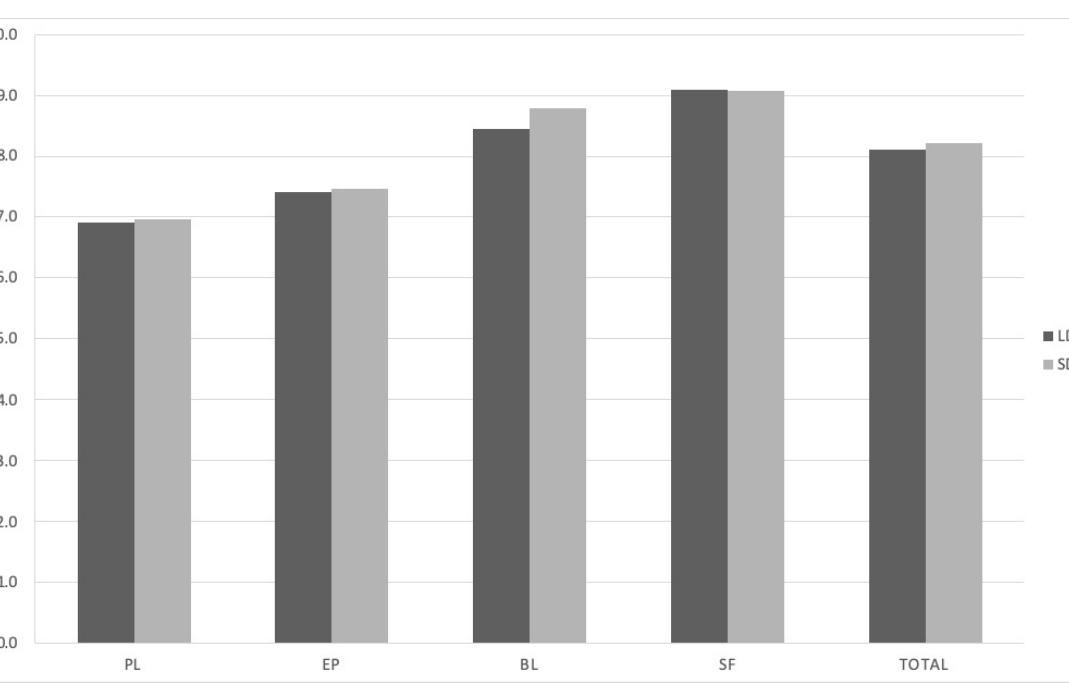
Figure 3. Assessment of the visibility of the four lesion types according to dose-mode (1 = very poor, 10 = perfect). Abbreviations: PL, periapical lesion; BL, recession of the buccal layer; EP, extended periodontal gap; SF, sequestrum/fracture; LD, low dose; and SD, standard dose.